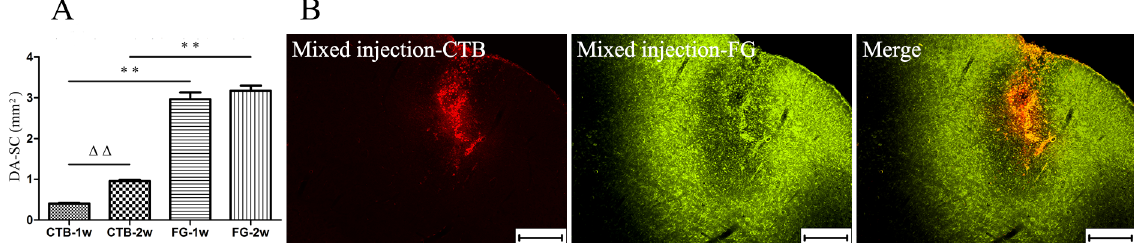
Fig 3. The diffusion area of cholera toxin subunit B (CTB) and Fluorogold(FG) in the superior colliculus (SC) at 1 week and 2 weeks in rats. (A) The diffusion area of tracers in the SC (DA-SC) in FG-1w (rats euthanized 1 week post-FG injection) and FG-2w (rats euthanized 2 weeks post-FG injection) were much larger than those in CTB-1w (rats euthanized 1 week post-CTB injection) and CTB-2w (rats euthanized 2 weeks post-CTB injection) (p < 0.001), CTB-2w displayed a larger DA-SC than CTB-1w (p < 0.005), but the DA-SC in FG-1w and FG-2w were similar (p = 0.513). (B) In an identical visual field of SC of a rat euthanized 2 week post-mixed injection (CTB+FG), the SC stained by CTB was focused and small, whereas the area stained by FG was diffuse and wide. ΔΔ Two-way analysis of variance (ANOVA), p < 0.001; (cid:3)(cid:3) two-way ANOVA, p < 0.001. Scale bar = 200